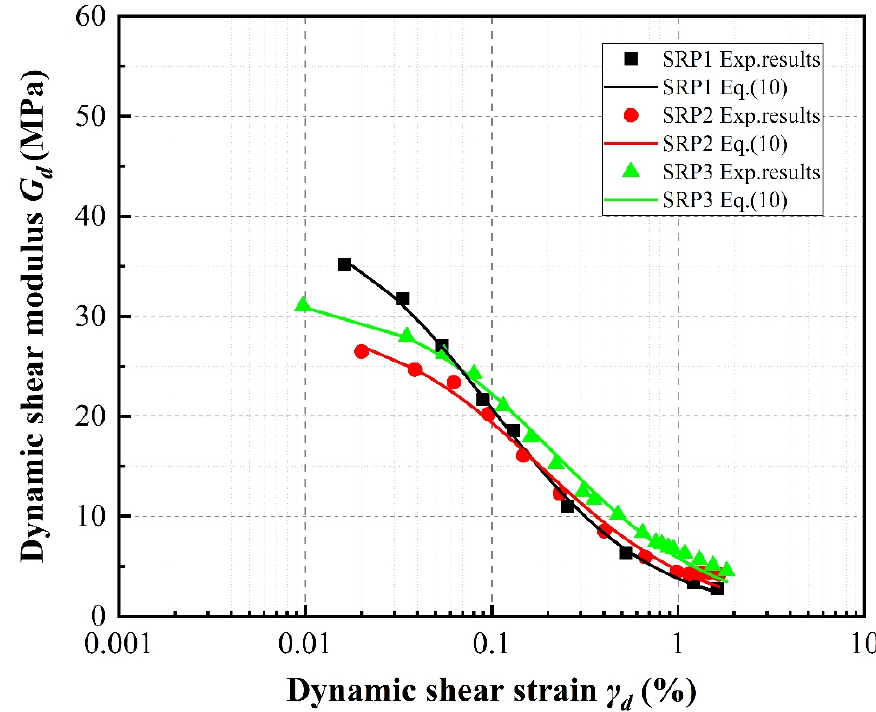
Figure 10. Effect of rubber particle size on dynamic shear moduli of sand–rubber mixtures with 20% rubber content under 100 kPa confining pressure.